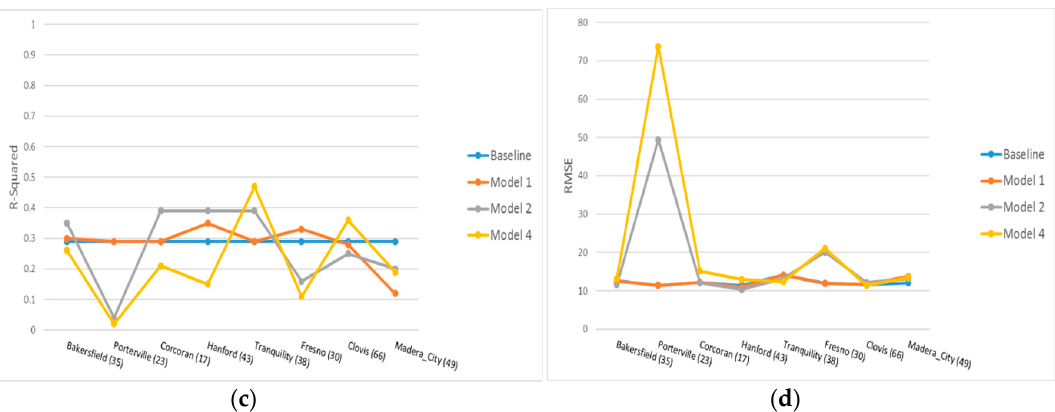
Figure 7. Stage 1 model fit (R-squared and RMSE) for calibration models fit on each DRAGON AERONET-PM2.5 site ( a , b ); and Stage 2 evaluation of these models by site on MISR data during the DRAGON field campaign ( c , d ). X -axes in all figures are sorted geographically from South (Bakersfield) to North (Madera city). ( a ) R 2 for different DRAGON-AERONET calibration models by site; ( b ) Estimated validation error (RMSE) for different DRAGON-AERONET calibration models by site; ( c ) Results of applying different statistical DRAGON-AERONET-based models by site on MISR data (R 2 ); ( d ) Estimated evaluation error (RMSE) from applying different statistical DRAGON-AERONET-based models by site on MISR data.